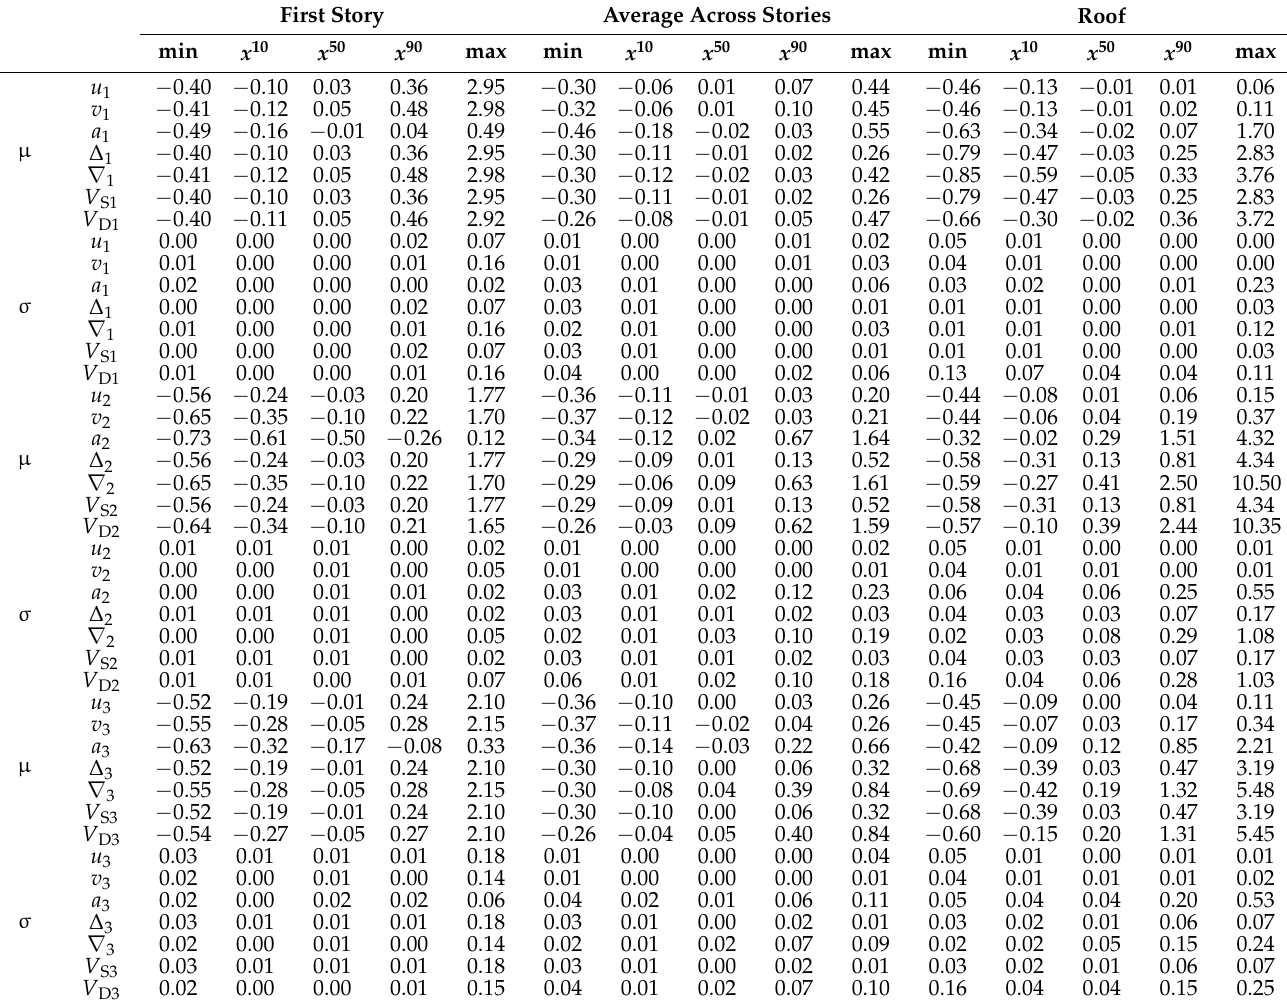
Table 3. Shear-type cases (B0- ∞ , B3- ∞ , B5- ∞ , C0- ∞ , C3- ∞ , C5- ∞ ), mean µ and standard deviation σ of error across